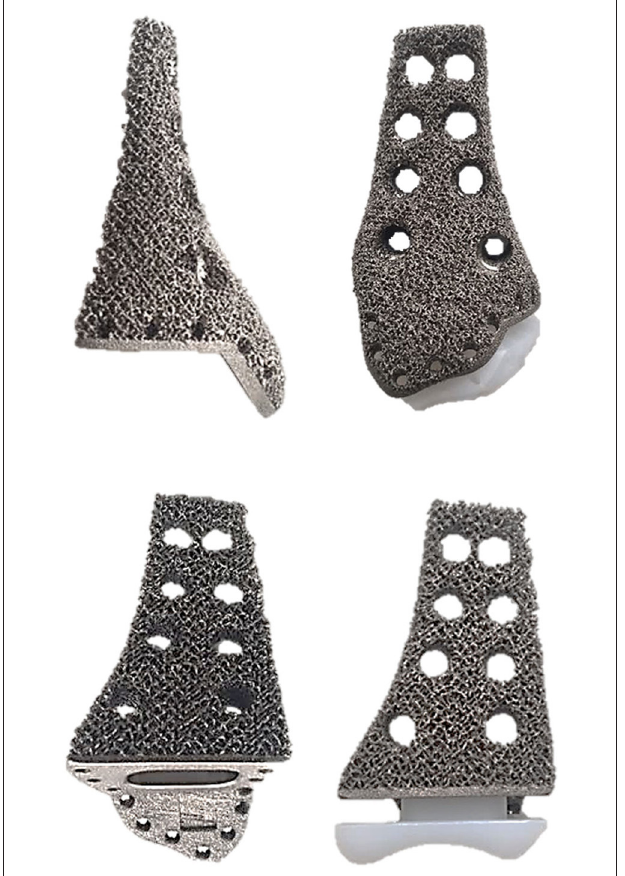
FIGURE 2 | Final product of 3D-printed